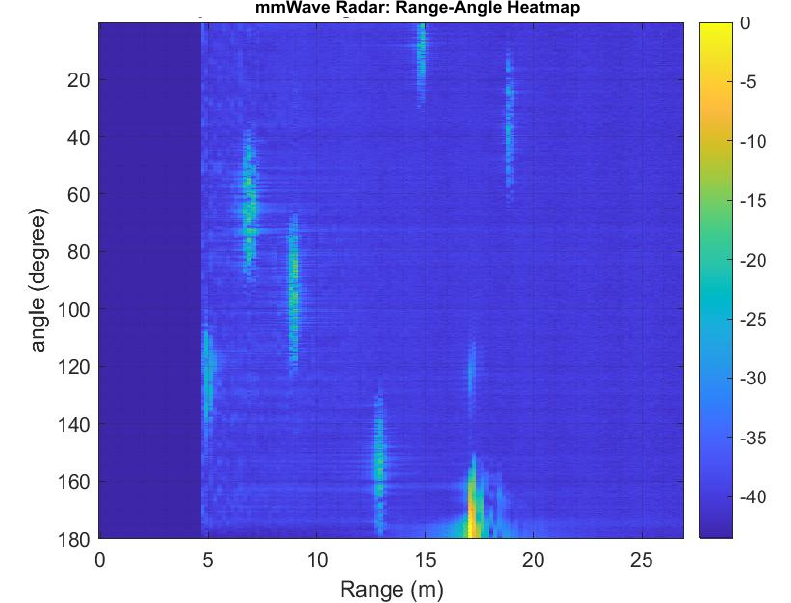
Figure 3. Range-angle map for multi-target measurement case-“e”.